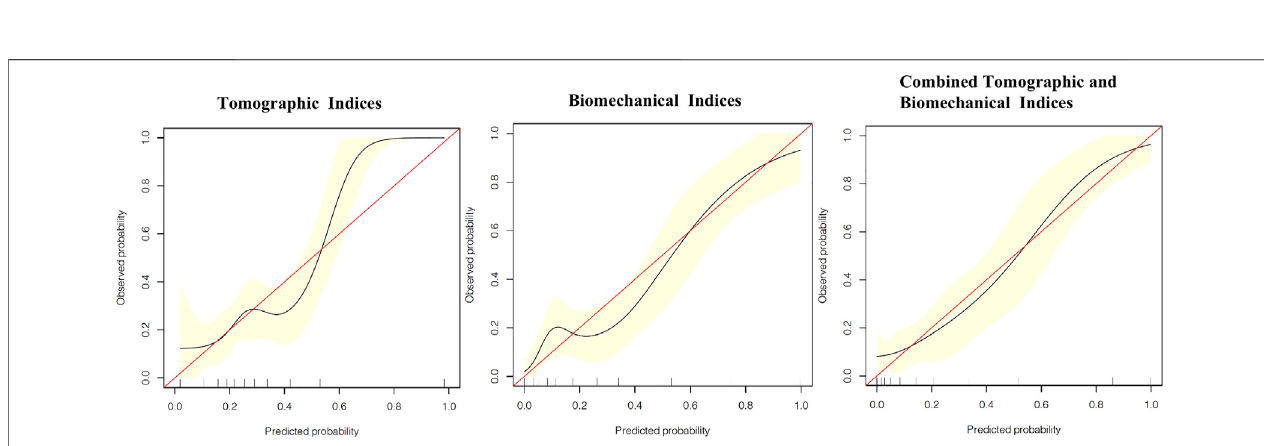
FIGURE 3 | Calibration curves showing the risk of developed-into-keratoconus in VAE-NT cornea according to tomographic indices, biomechanical indices, and combined tomographic and biomechanical indices.